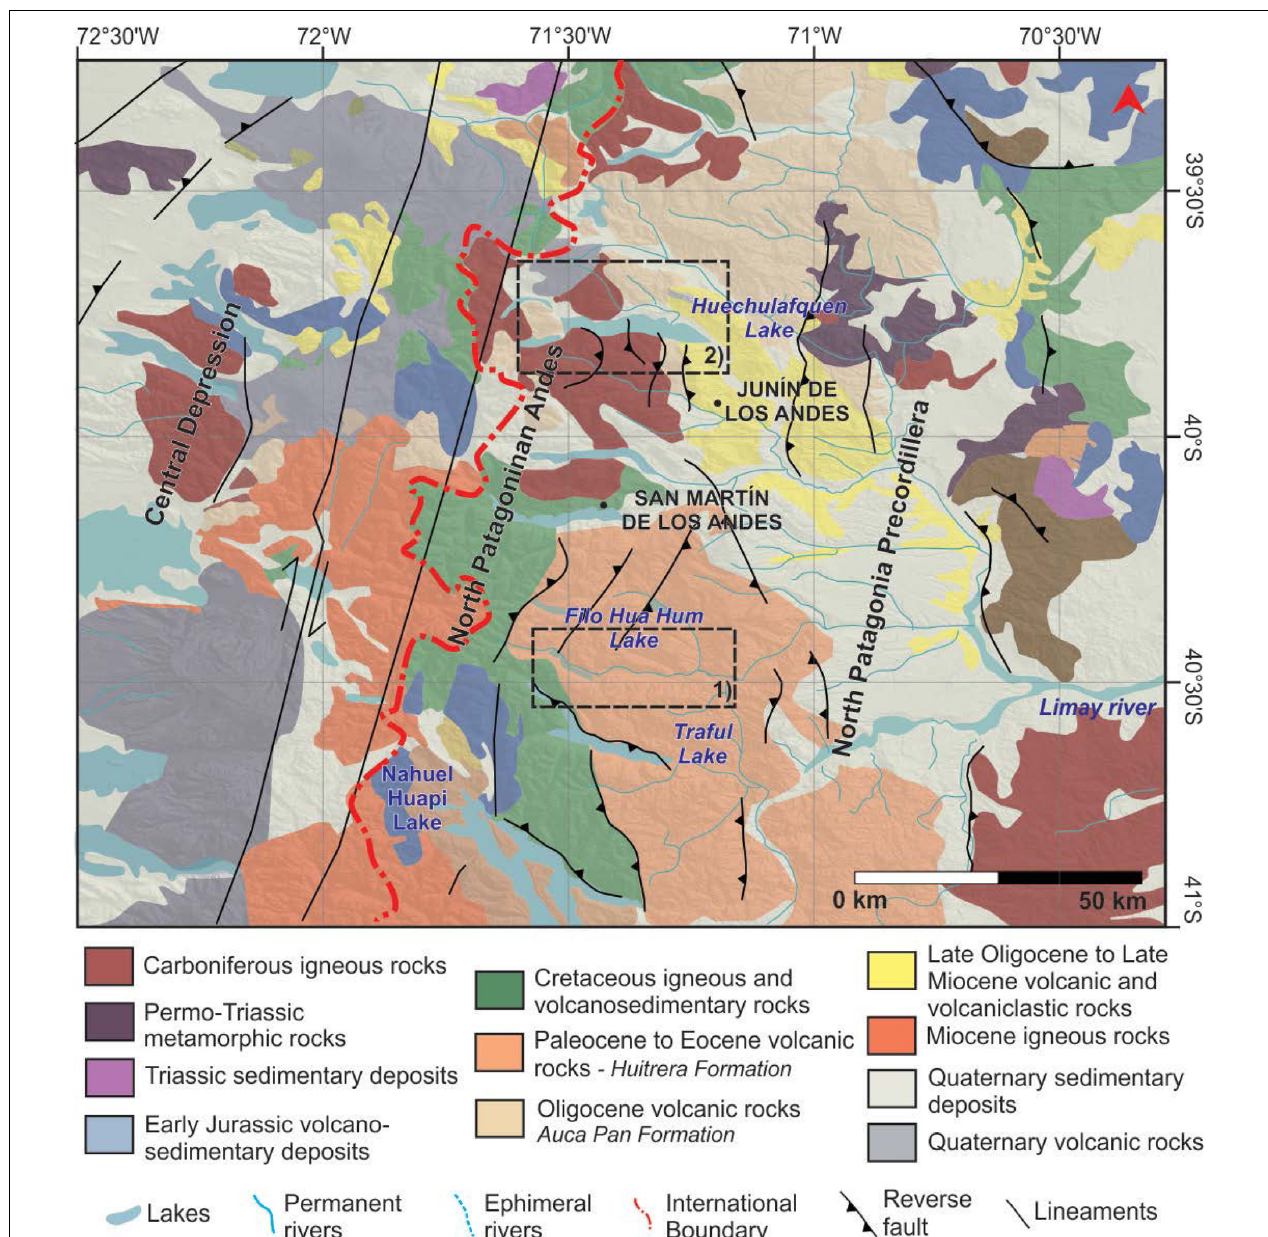
FIGURE 3 | Detailed map of the studied areas. The boxes outline the main studied areas, where (1) Paleocene to Eocene volcanic rocks crop out associated with the studied Huitrera Formation (44 Ma) and (2) Oligocene volcanic rocks appear related to the studied Auca Pan Formation (29 Ma). Modified from Ramos et al. (2014); Lucassen et al. (2004), Scasso (2012), Cazau et al. (1989), Rapela et al. (1983), and Iannelli et al.